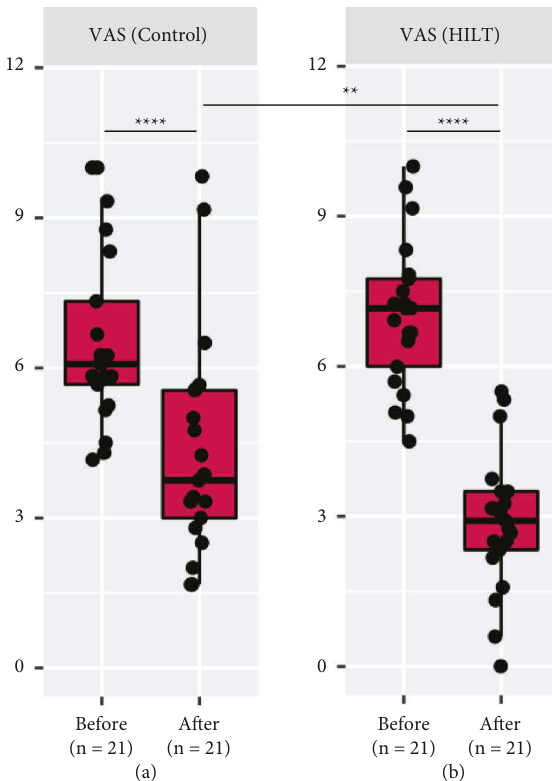
Figure 2: Box plot showing overall analysis of changes in the VAS scores within the same group and compared between the groups. (a). Change in the VAS score in the control group compared before and after treatment completion. (b). Change in the VAS score in the HILT groupcomparedbeforeandaftertreatmentcompletion.Dataareshown as ns (not significant) � p value > 0.05, ∗ � p value < 0.05, ∗∗ � p value < 0.01, ∗∗∗ � p value < 0.001, and ∗∗∗∗ � p value < 0.0001. HILT, high-intensity laser therapy; VAS, visual analogue scale.